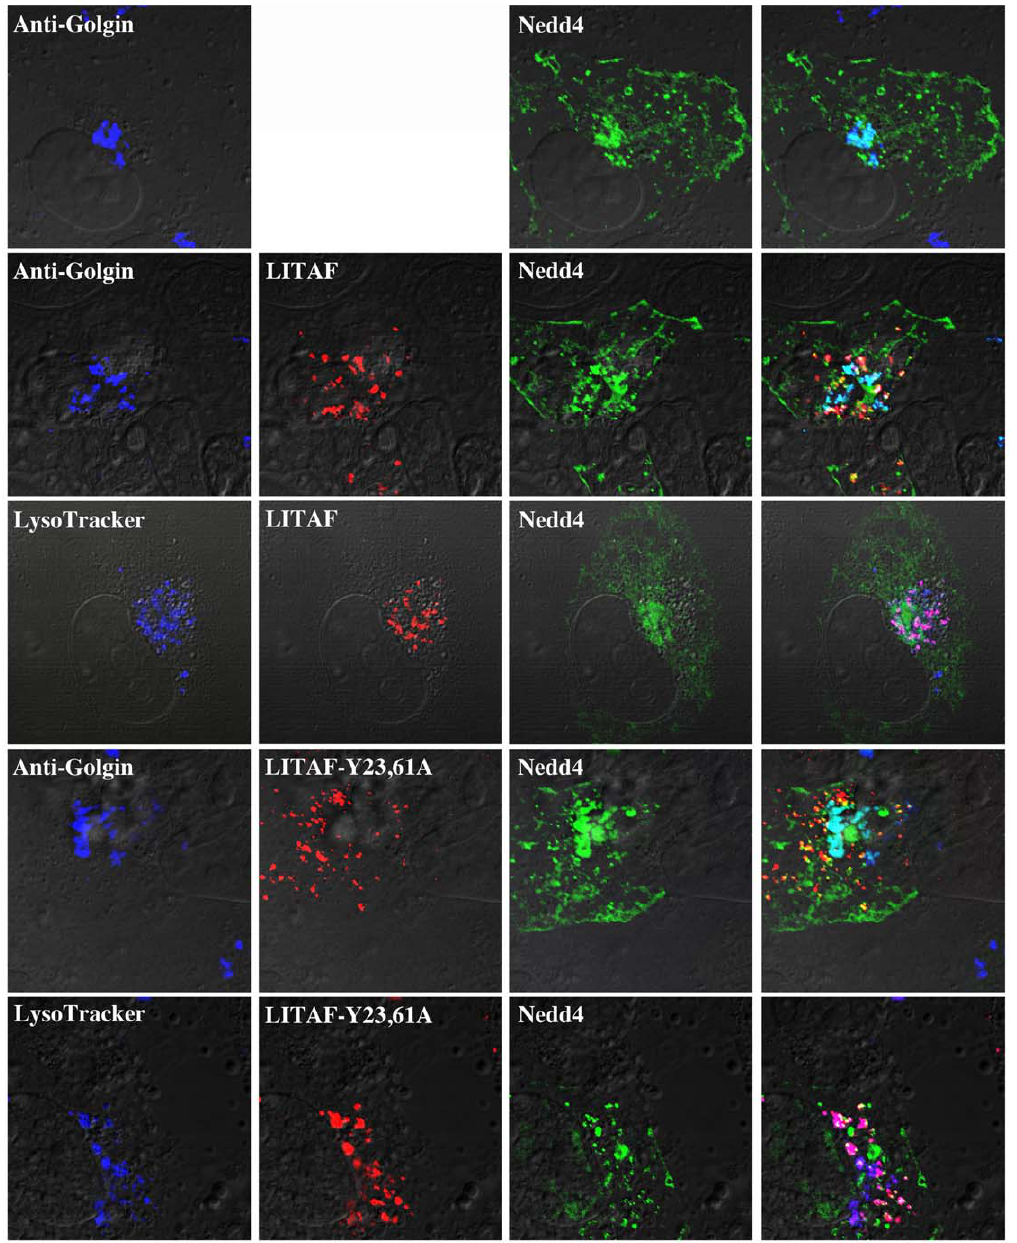
red), Nedd4 (green), lysosomes (LysoTracker; blue) and the Golgi apparatus (anti-Golgin; blue). Cells were visualized using DIC.